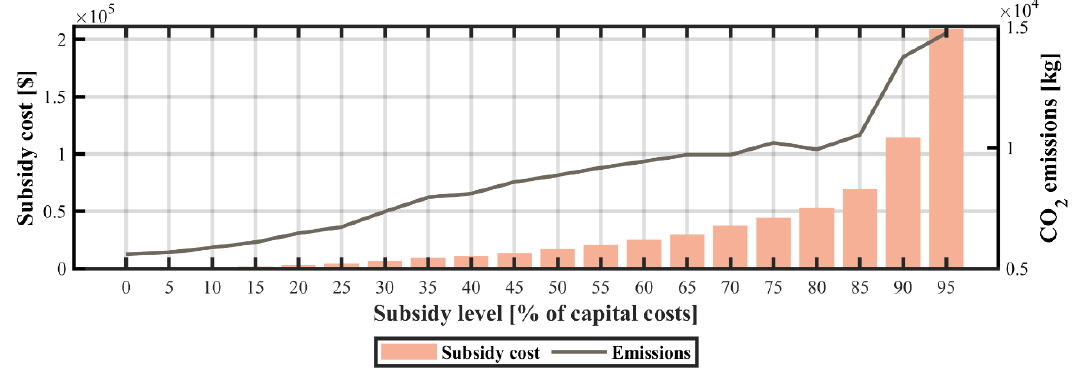
Figure 16. Simulation results of capital subsidies for wind technologies. Impact on subsidy costs and CO 2 emission levels.